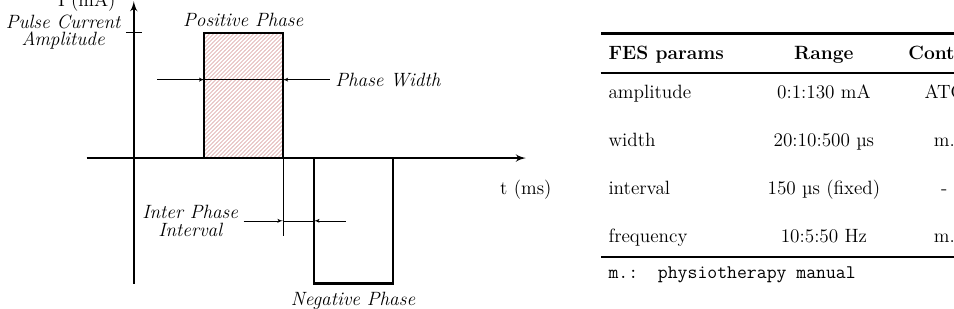
Figure 4. Rectangular biphasic current pulse generated by RehaStim 2 stimulator and its